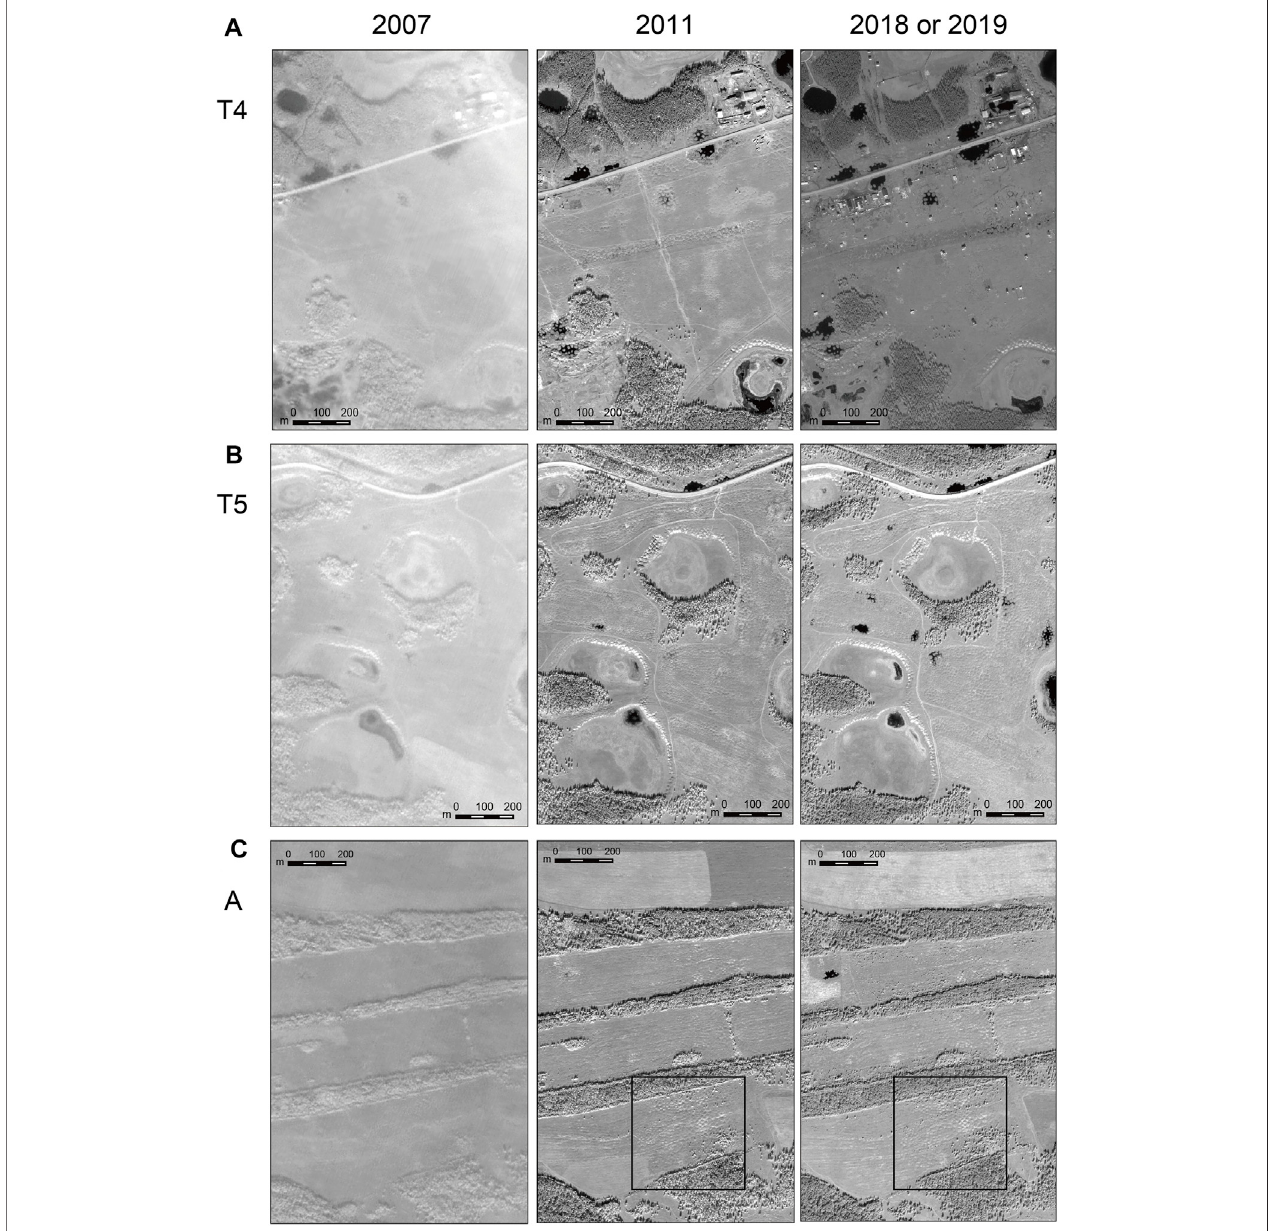
FIGURE 6 | Comparison of the visible images in areas (A) T4, (B) T5, and (C) A (as shown in Figure 2B ), derived from ALOS-PRISM in September 2007 (left) , WorldView in September 2011 (center) , and WorldView in September 2018 or August 2019 (right) . The rectangle in (C) shows the enlarged area in Figure 8 .